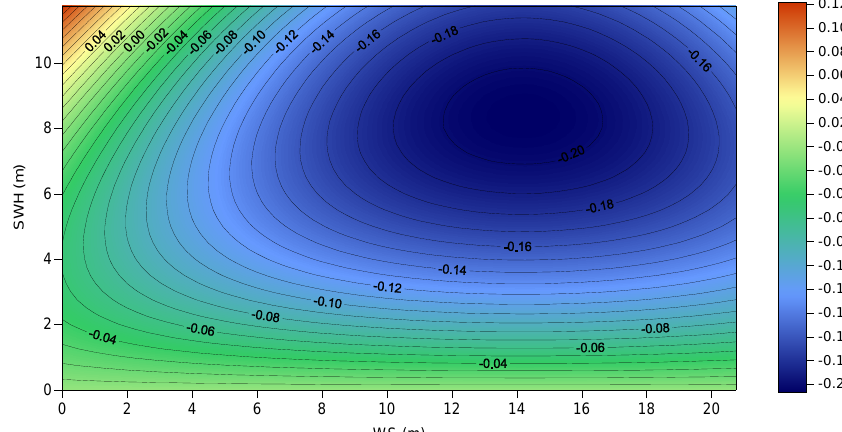
Figure 12a – Chambers SSB model for TOPEX B (metres).